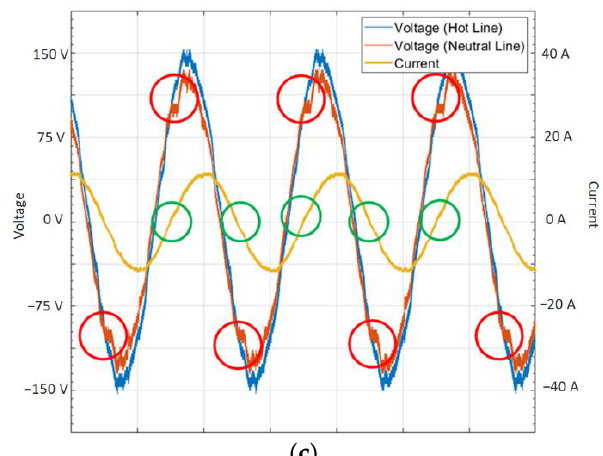
Figure 4. The voltage and current waveforms in the arcing state. The red circles show the voltage drops at every zero-crossing point of the current. The green circles show where the current shoulder occurs. ( a ) A significant voltage drop and a longer current shoulder for a 100 W load. The greater power draw by the load results in a smaller current difference and drop between the hot and neutral lines. ( b ) The current shoulder and voltage drop for a 400 W load. ( c ) The current shoulder and voltage drop for an 833 W load.